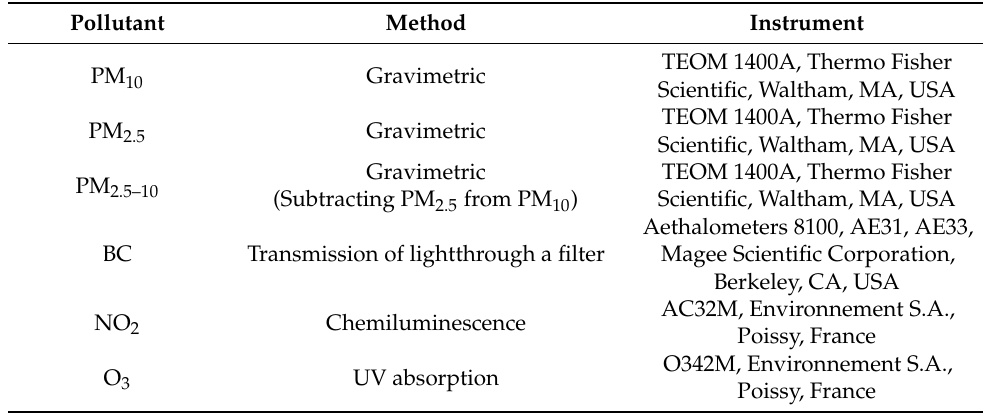
Table 1. Measurement methods and instruments used to measure the